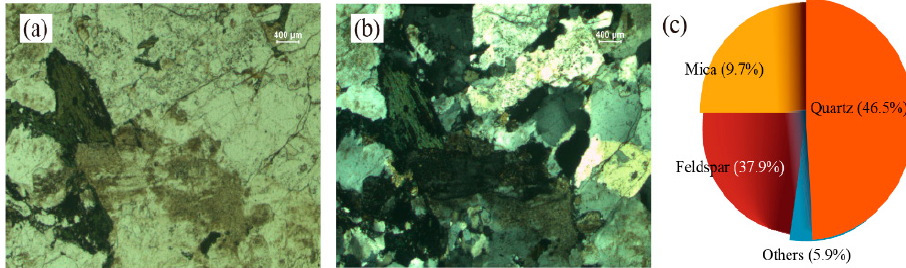
Figure 1. Micrographs of selected granite material: ( a ) single-polarized micrograph, ( b ) cross-polarized micrograph, ( c ) minerals composition.